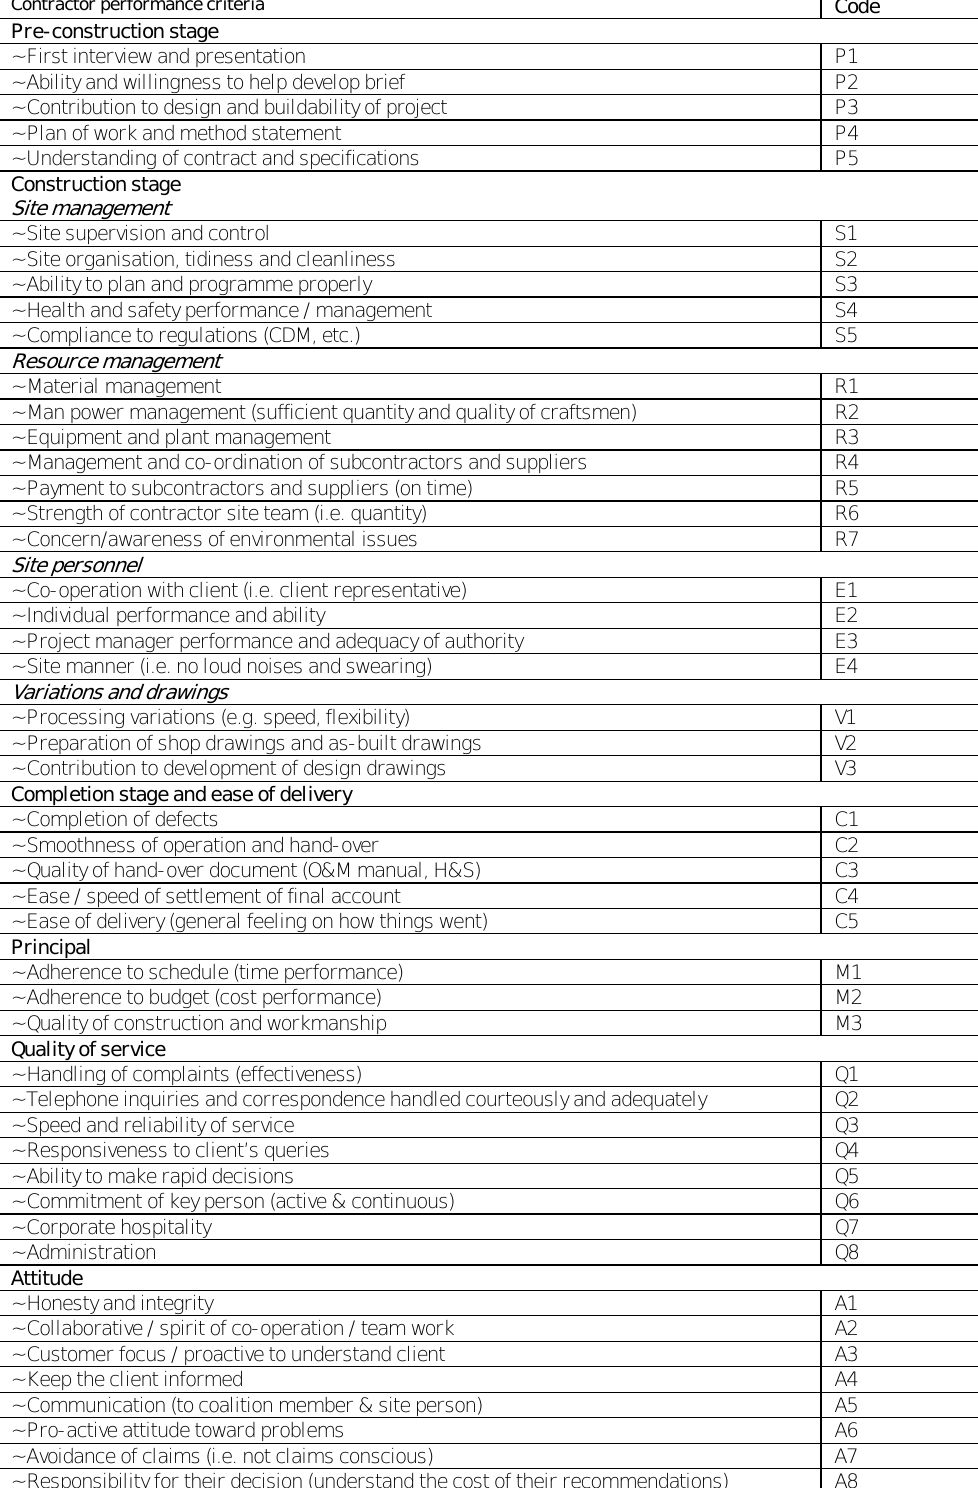
Table 2: List of contractor performance criteria based on clients' opinion Contractor performance criteria